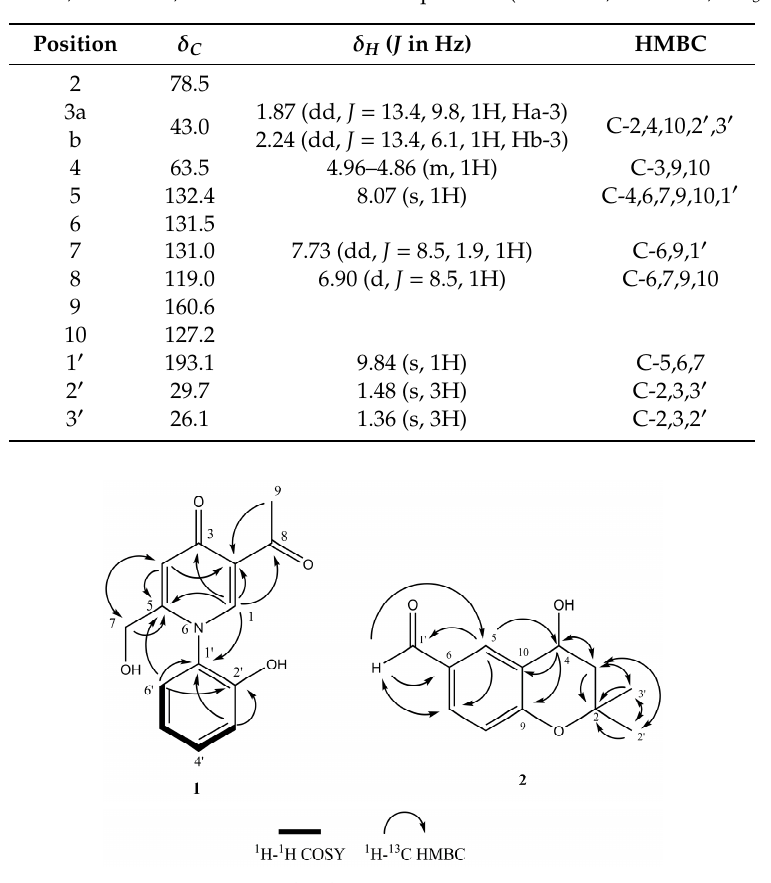
Figure 4. Selected HMBC and 1 H- 1 H COSY correlations of compounds 1 and 2 . Table 1. 1 H, 13 C NMR, COSY, and HMBC data of compound 1 (400 MHz, 100 MHz; CD 3 OD).